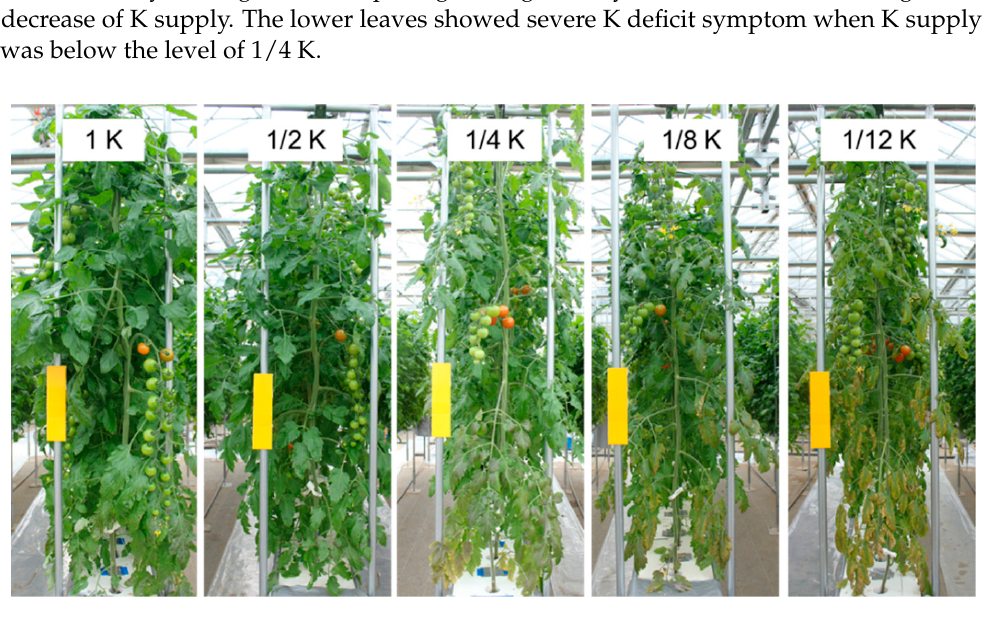
Figure 4. Cumulative water uptake per plant under five quantitative K-supply regimes for four months in hydroponically grown cherry-type tomato ‘Carol 10’.